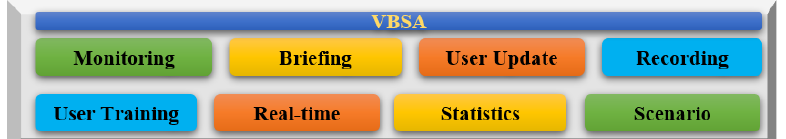
Figure 4. Modes of operations of Voice-Based Synthetic Assistant (VBSA) (reproduced from